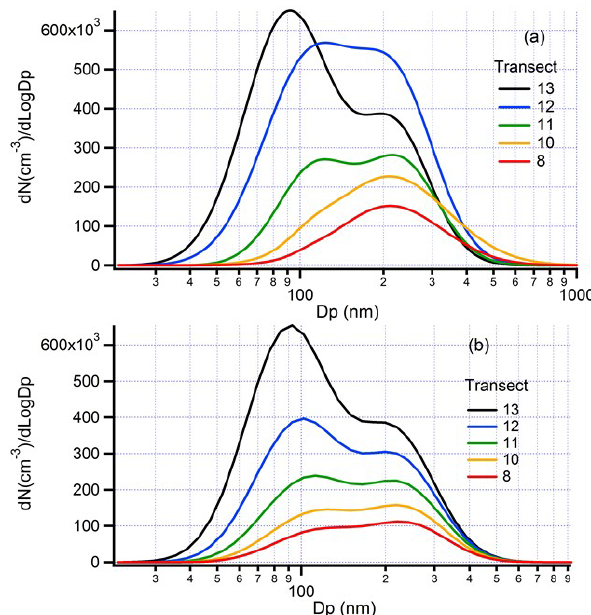
Figure 19. Aerosol size distribution for five transects on the along- plume segment of 821b (see Fig. 7). (a) FIMS data extrapolated to 1000nm using a double log normal. (b) Corresponding results of coagulation calculation initiated with FIMS size distribution on transect 13. Coagulation calculations include a factor of 4 dilution between transects 13 and 7 (not shown in the plot for